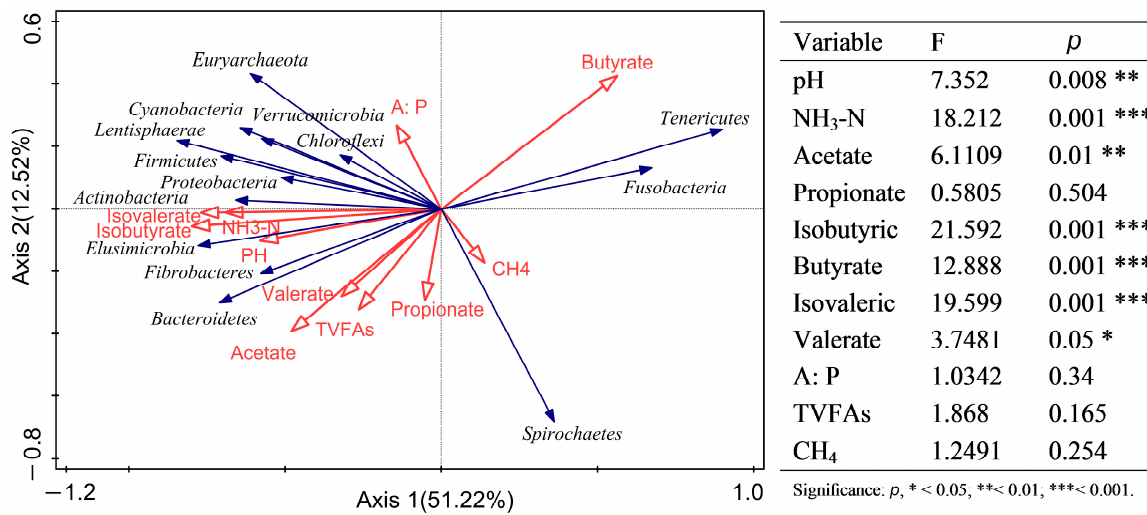
Figure 4. Redundancy analysis (RDA) of ruminal fermentation parameters and prokaryotic community compositions at the phylum level. Arrows indicate the direction and magnitude of parameters associated with prokaryotic community structures. A:P, acetate and propionic ratio; TVFAs, total volatile fatty acids.